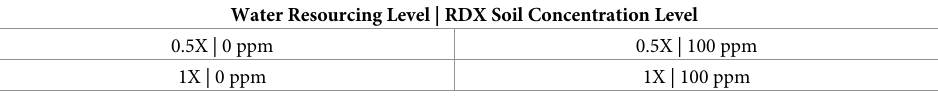
Table 3. Water-resource and RDX soil concentration treatment classes employed in outdoor plot trial.